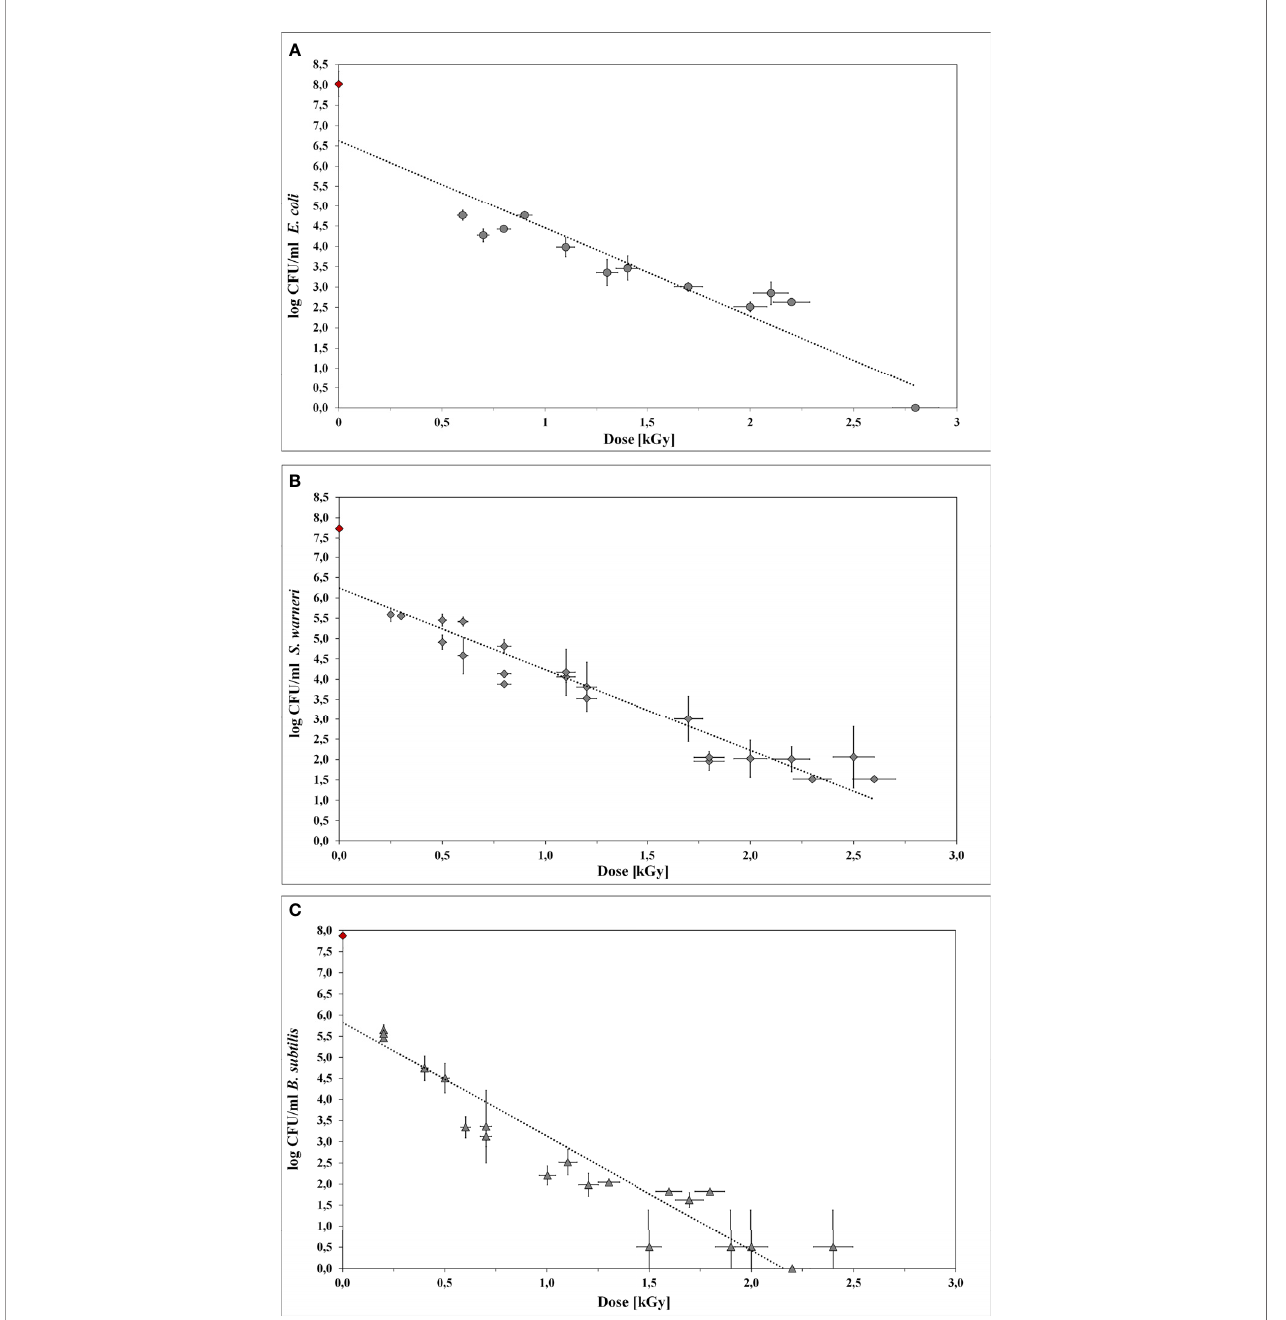
FIGURE 4 | Inactivation curves using LEEI. Each curve represents the mean values of at least three irradiated bacterial suspensions. The initial cell number of the pre-culture (indicated as red rhombus) was approx. 10 8 bacteria/ml. The starting total cell number for the experiments was 10 6 bacteria/ml. (A) E coli. (B) S. warneri . (C) Vegetative cells of B. subtilis